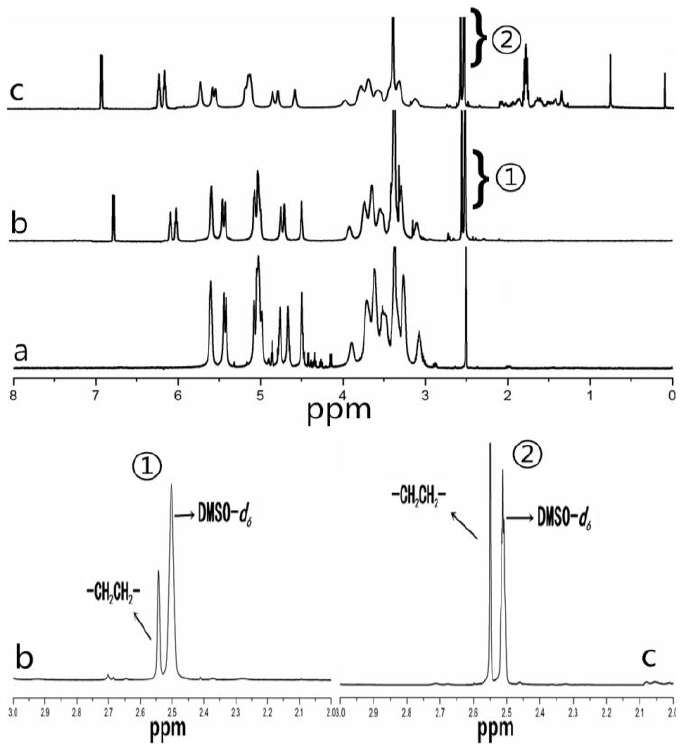
Figure 3. 1 H-NMR spectra for pullulan ( a ); amino-pullulan ( b ); and CHAP ( c ).